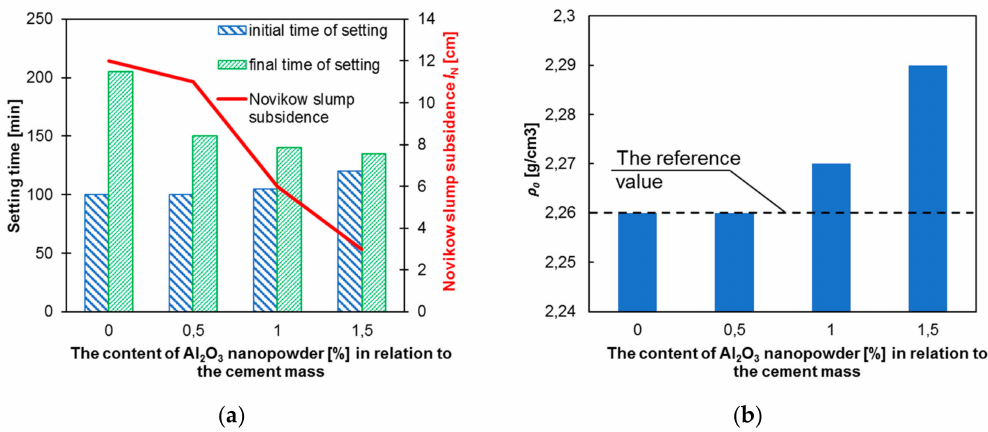
Figure 5. Test results of fresh cement mortars: ( a ) Novikow slump test and setting times; ( b ) bulk